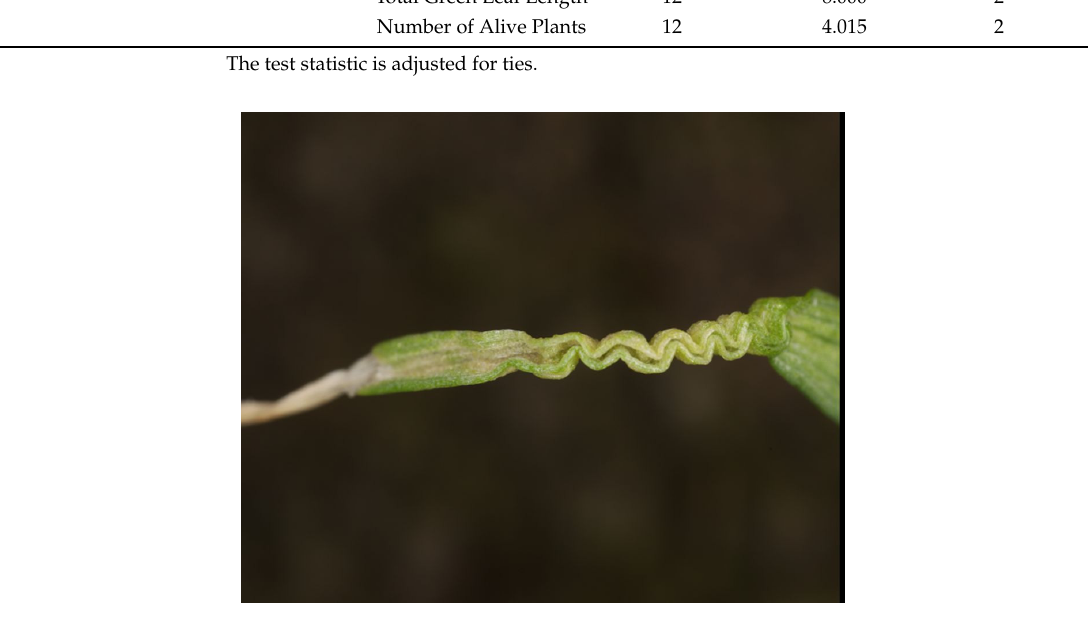
Figure 3. Close-up of “concertina” leaf deformation 4 DAT on Lolium multiflorum plants treated with 5 J at 6 kV.